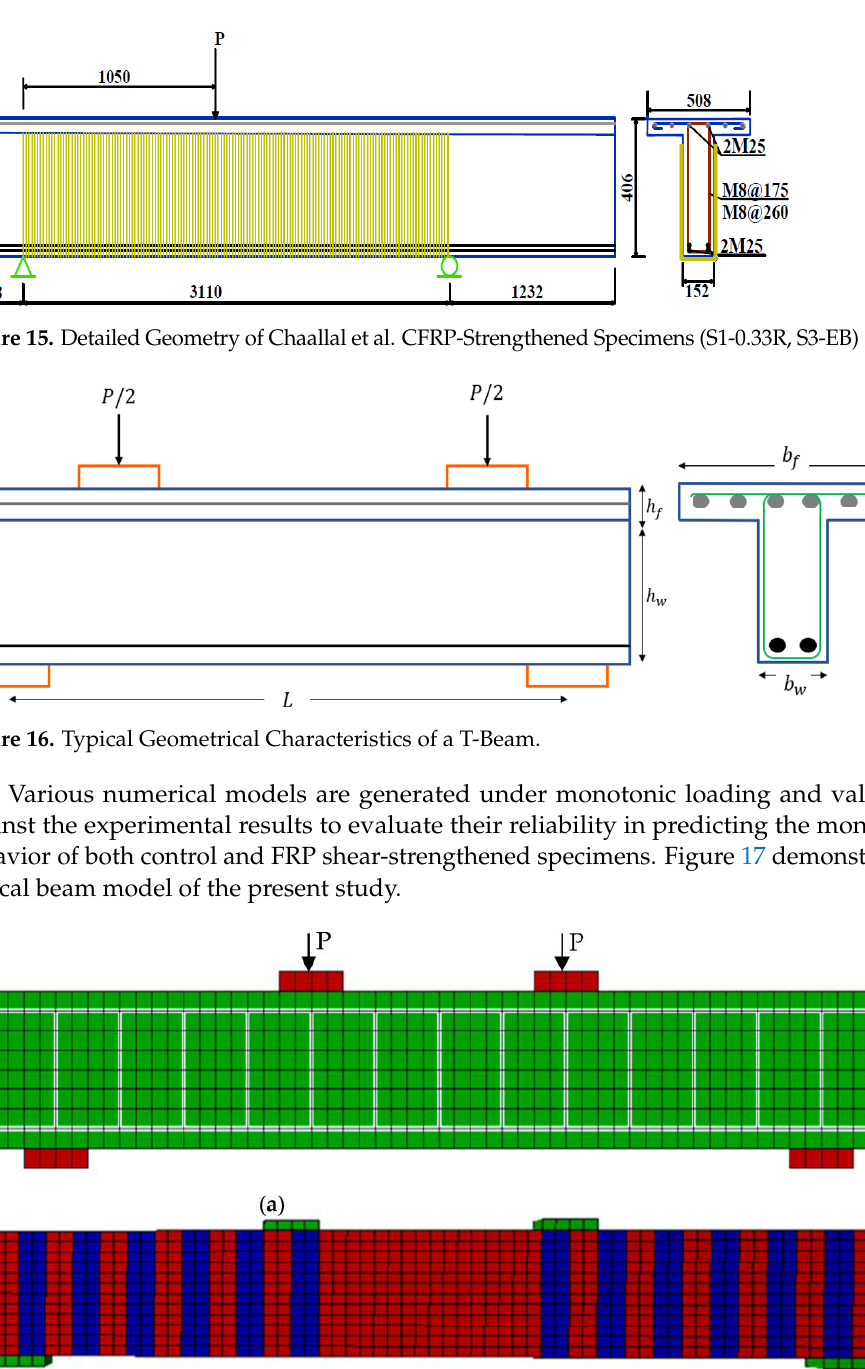
Figure 14. Detailed Geometry of Chaallal et al. Control Specimens (CON-S0, CON-S1, CON-S3) [53], [54].